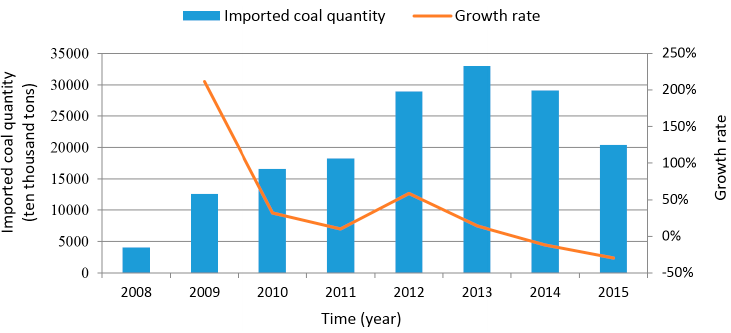
Figure 3. Historical data of imported coal quantity and the growth rate.